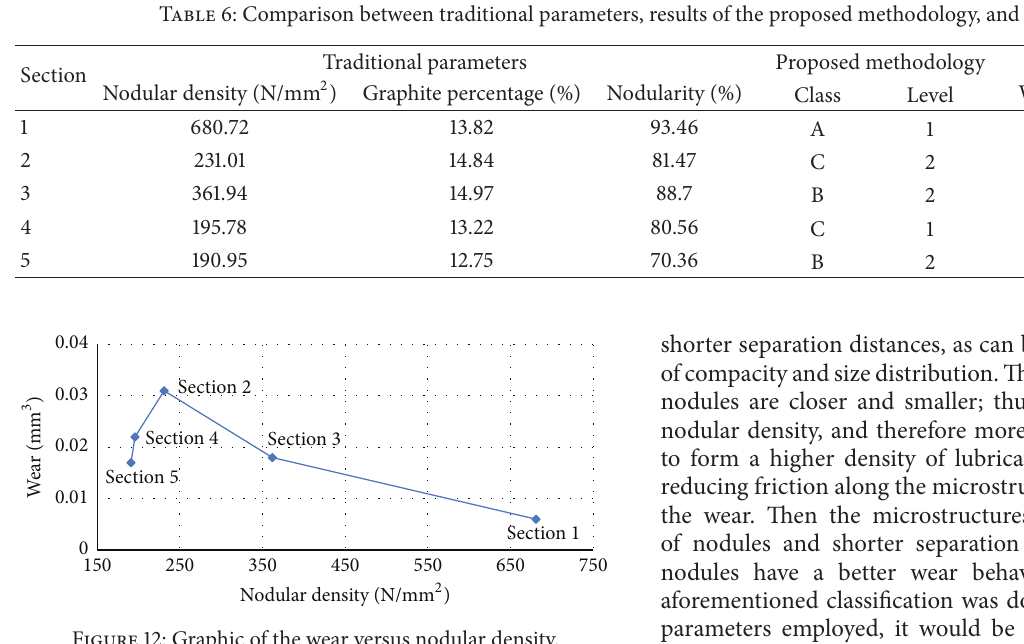
Figure 12: Graphic of the wear versus nodular density.